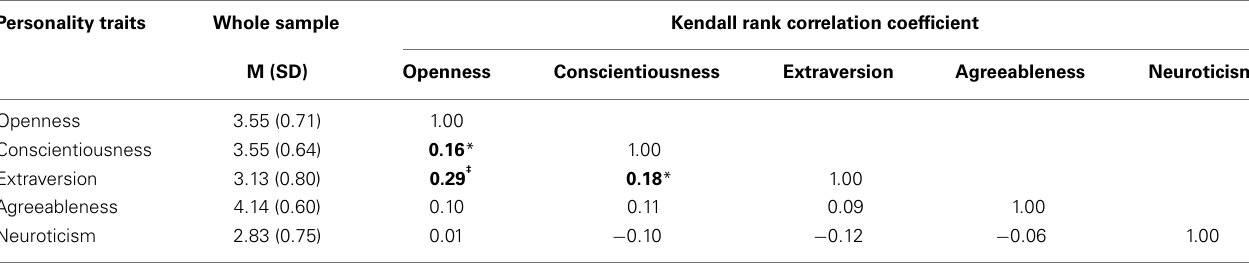
Table 2 | Means and correlation coefficients of personality traits .